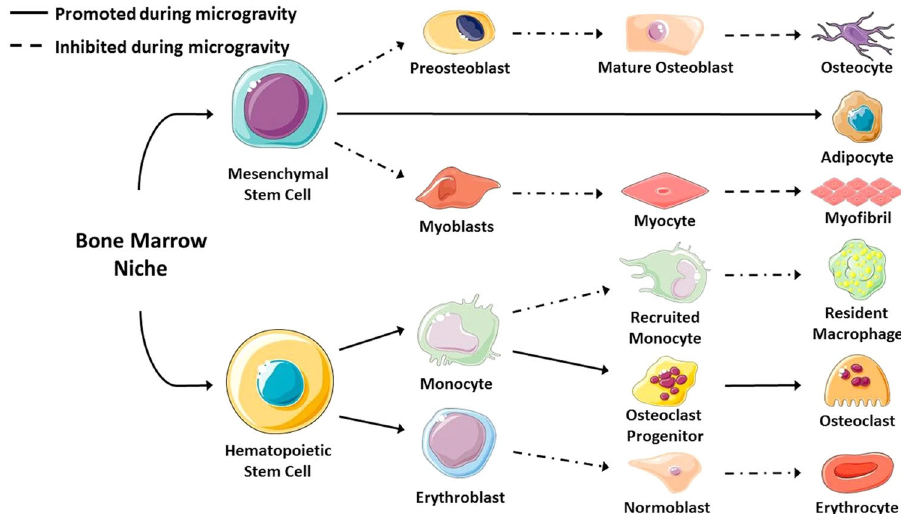
Fig. 2 Differentiation of cell lines depending on gravity. The faith of the cells is strongly affected by gravity. Mesenchymal stem cells mainly differentiate in adipocytes, while hematopoietic stem cells move toward the osteoclast pathway 3 (in compliance with CC BY 4.0 License —